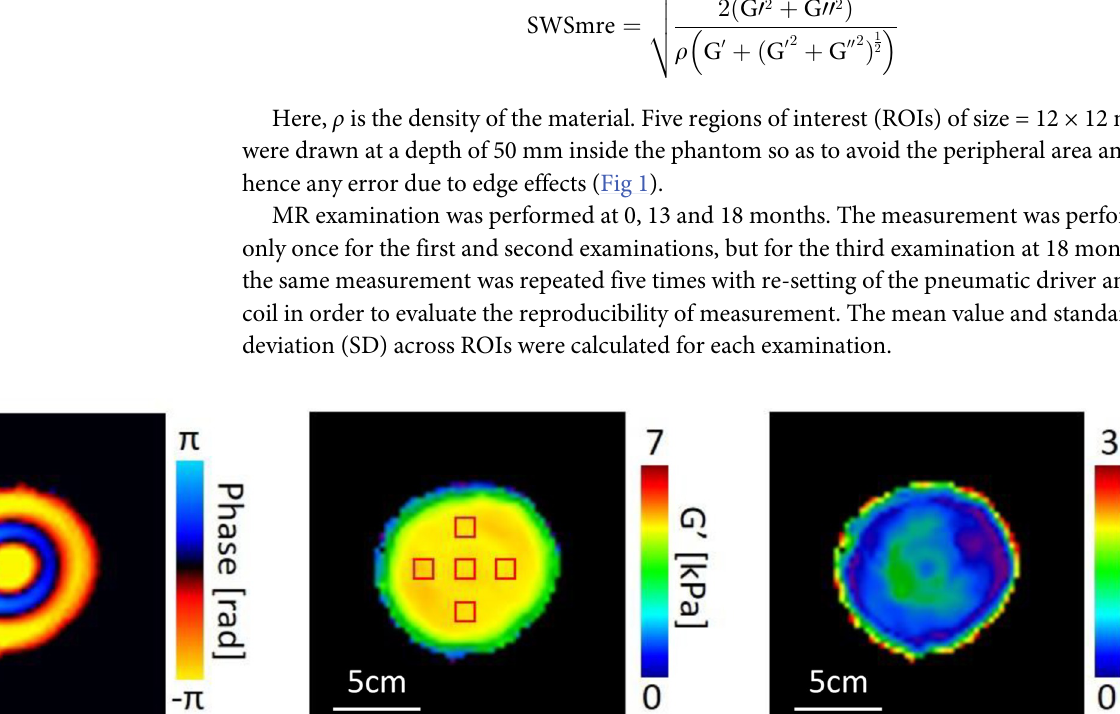
PLOS ONE | https://doi.org/10.1371/journal.pone.0250667 May 21,